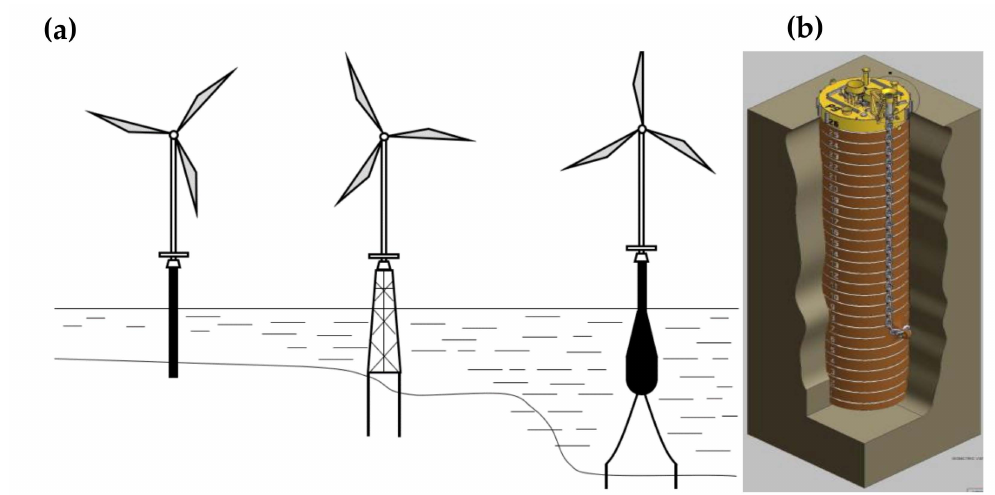
Figure 1. Typical foundation types for o ff shore wind turbines: ( a ) o ff shore wind turbines; ( b ) suction caisson